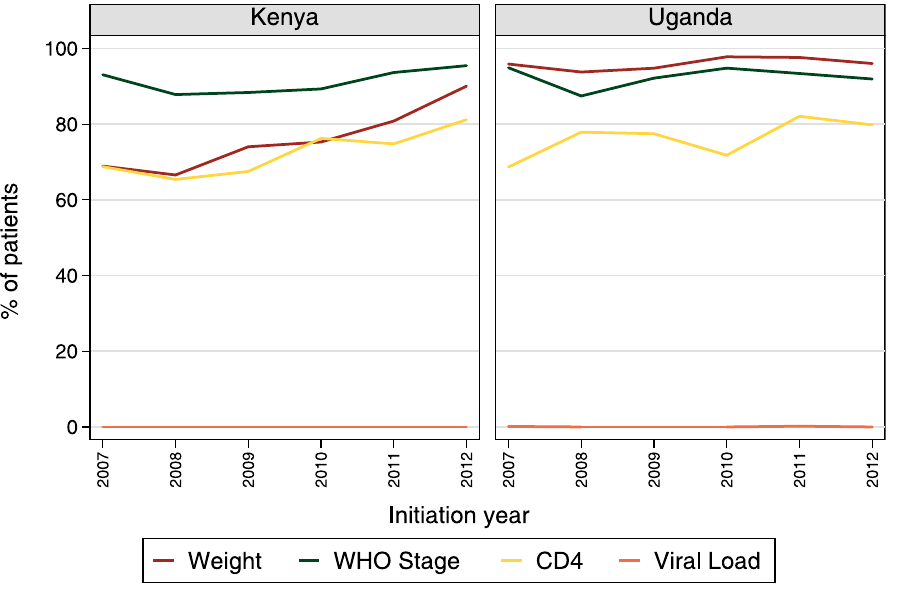
Fig 1. Percent of patients receiving baseline measurements by initiation year, 2007 –